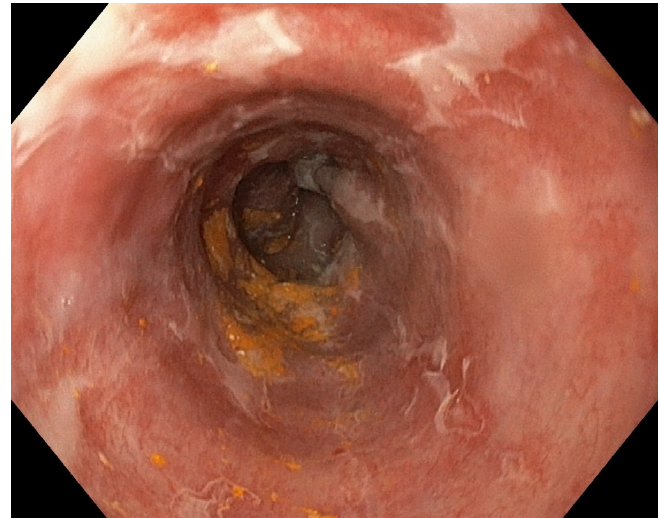
Figure 4. Endoscopic check-up revealed persistent ulcerations covered by white exudates that raised the suspicion of esophageal candidiasis. One week later, endoscopic check-up showed persistent esophageal ulcers covered by white exudates and biopsies were performed to exclude an esophageal candidiasis, but they were negative (Figures 4 and 5).